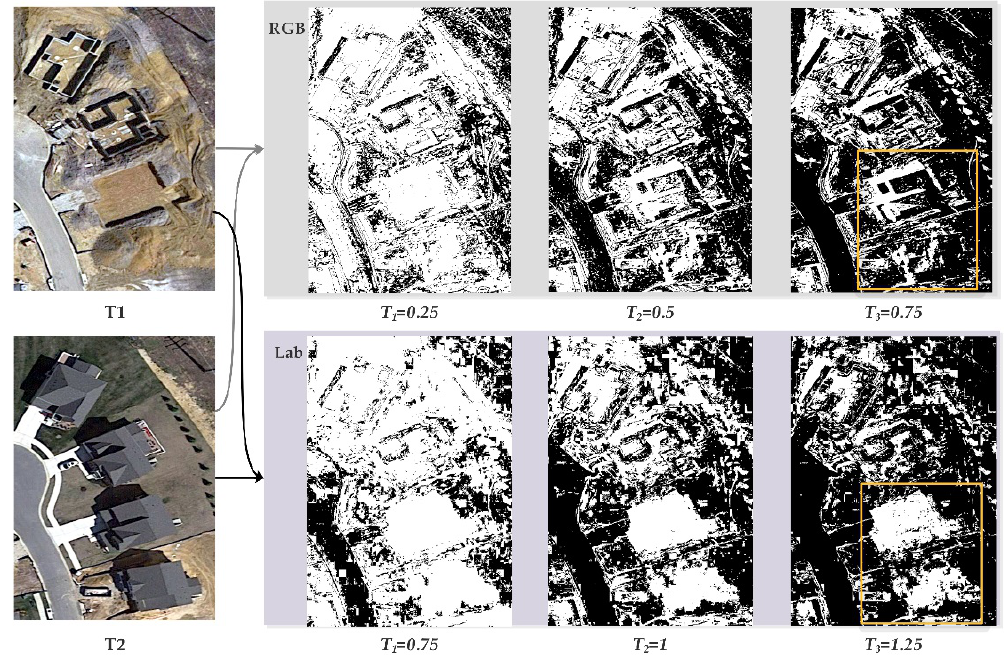
Figure 2. Changed pixels in RGB and Lab color spaces obtained with different T values. Although the increment of T is similarly set to 0.25, the contrasting images exhibit different degrees in the two-color